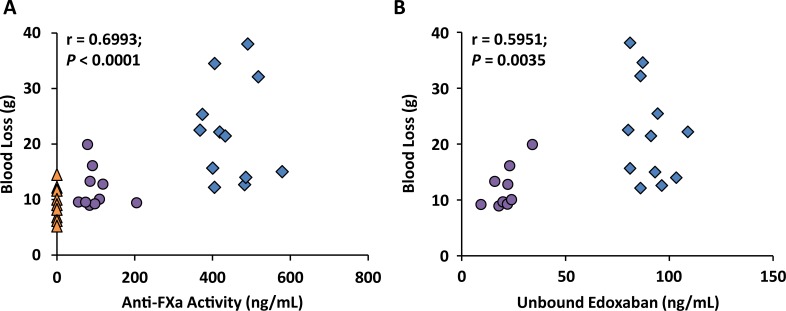
Correlation between blood loss and pharmacodynamic markers in edoxaban-anticoagulated rabbits.Blood loss correlated with (A) anti-FXa activity and (B) unbound edoxaban plasma concentrations. Each data point represents the measurements from an individual rabbit at the end of andexanet infusion (Time 25 minutes) for anti-FXa and unbound edoxaban, and 15 minutes after liver injury for blood loss (Time 40 minutes). △ vehicle alone (both edoxaban + andexanet vehicle); ○ edoxaban + andexanet; ◇ edoxaban + andexanet vehicle.